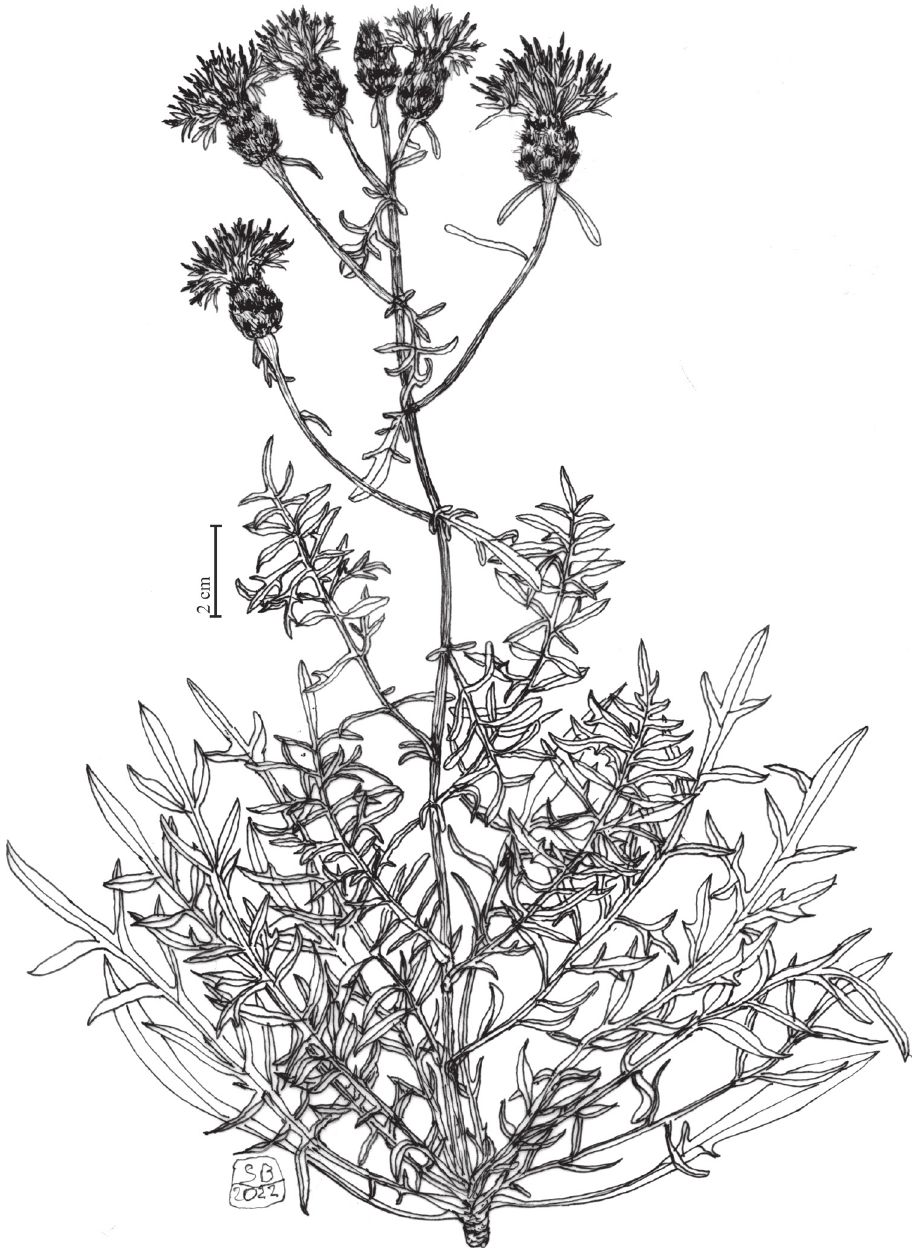
Figure 1. Habit of Centaurea lovricii sp. nov. Drawn by Salvatore